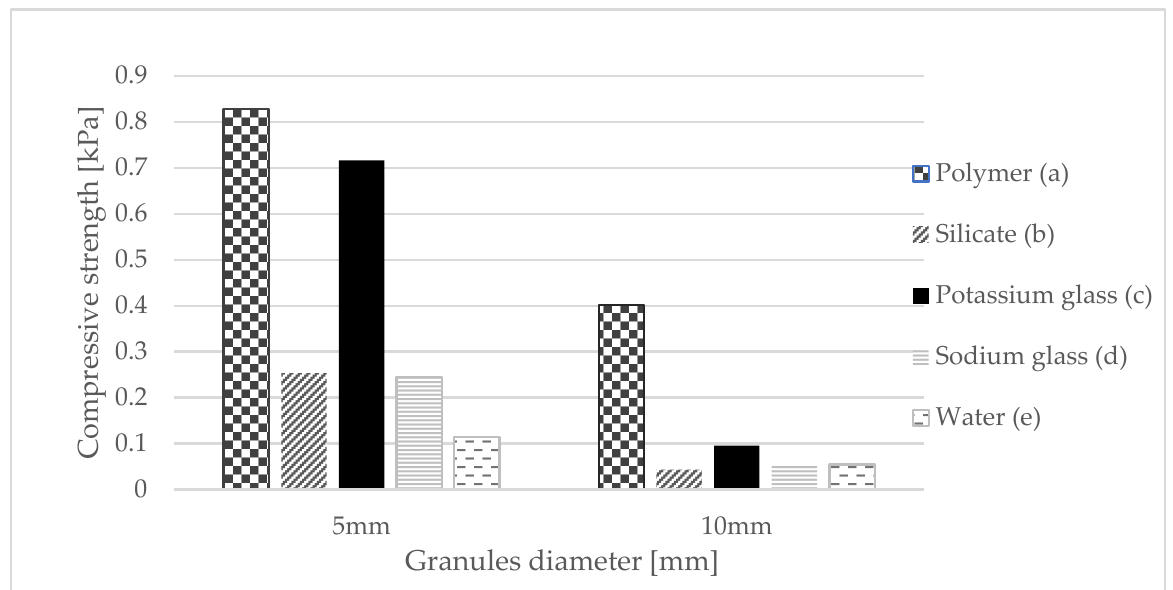
Figure 5. Compressive strength of granules 5 mm and 10 mm in diameter, coated with (a) polymer; (b) silicate; (c) potassium glass; (d) sodium glass; and (e) water .